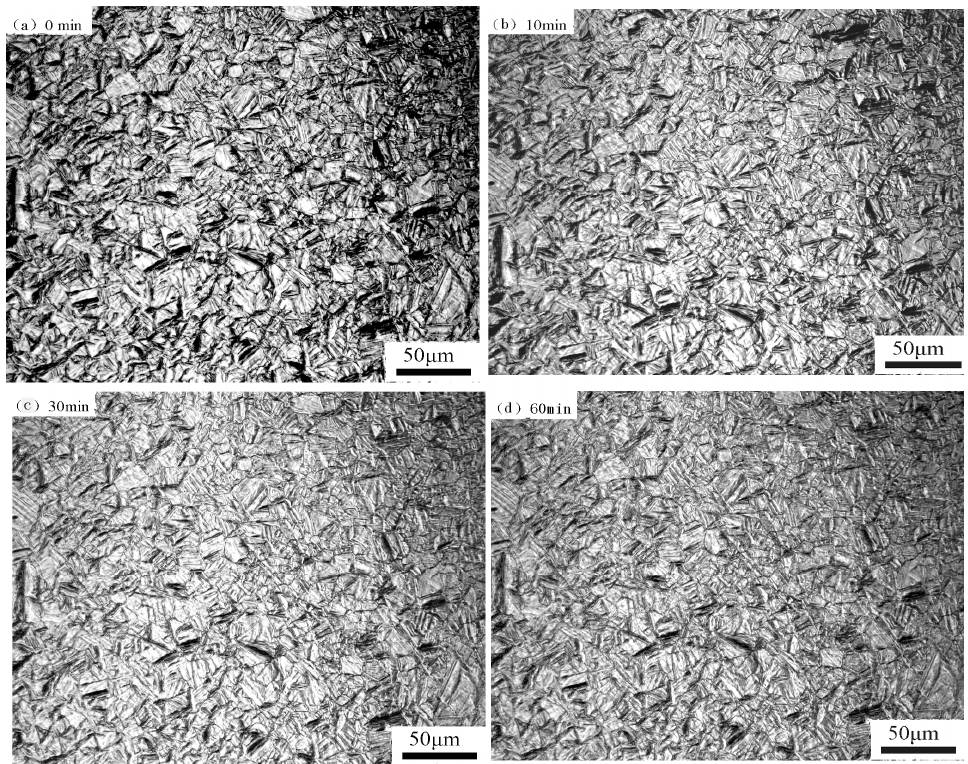
Figure 8. In situ observation of reverted austenite transformation of the 13Cr supermartensitic stainless steel tempered at 620 °C for different times: ( a ) 0 min, ( b ) 10 min, ( c ) 30 min, ( d ) 60 min.